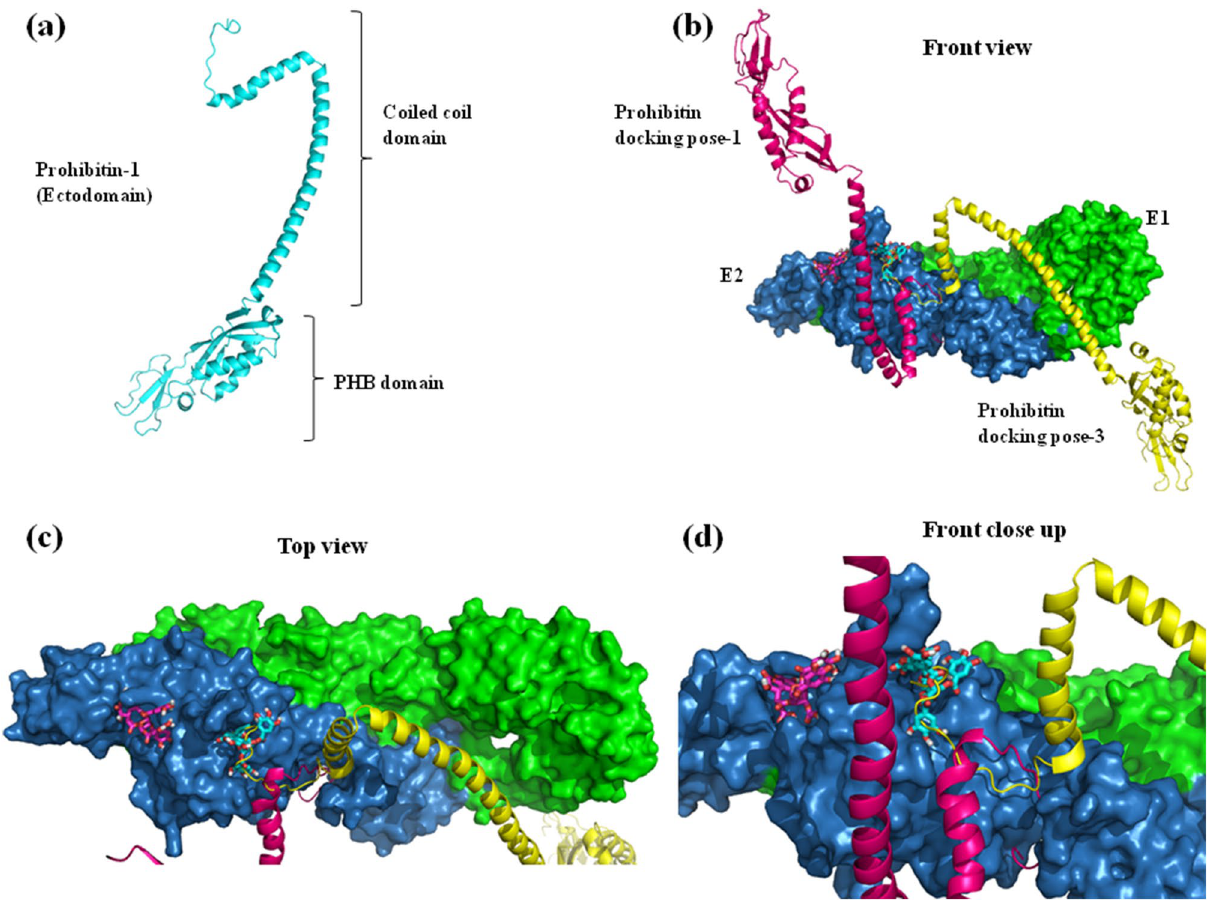
Figure 7. Structural depiction of prohibitin-1, CHIKV envelope glycoprotein E1-E2 heterodimer and their docked conformations. ( a ) Model structure of prohibitin ectodomain, generated using the SWISS-MODEL software 54 . The protein is depicted in cartoon presentation of protein backbone (cyan), showing the N-terminal prohibitin (PHB) and C-terminal coiled coil domains. ( b ) Front view of the docked conformations of prohibitin and CHIKV E1-E2 heterodimer. The E1 and E2 subunits are depicted in surface presentation with green and blue color schemes, respectively. The first and third docked conformations of prohibitin are shown in cartoon presentation in magenta and yellow color schemes. ( c ) The top view of the docked conformations of prohibitin and CHIKV E1-E2 heterodimer. ( d ) The close-up of the front view of the docked conformations of prohibitin and CHIKV E1–E2 heterodimer. These diagrams have been prepared using the molecular visualization system PyMOL 47